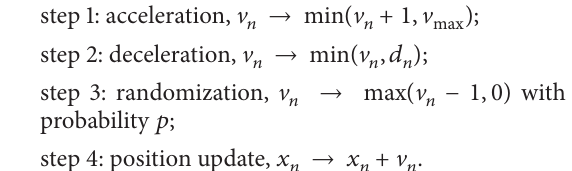
Figure 1: Origination of U-turn movement at the intersection. Three types vehicles need make U-turn movements at the nearest intersections: (1) vehicles which move the opposite direction; (2) vehicles which are forbidden to make direct left-turn movement at the intersection; (3) vehicles which turn left from a minor